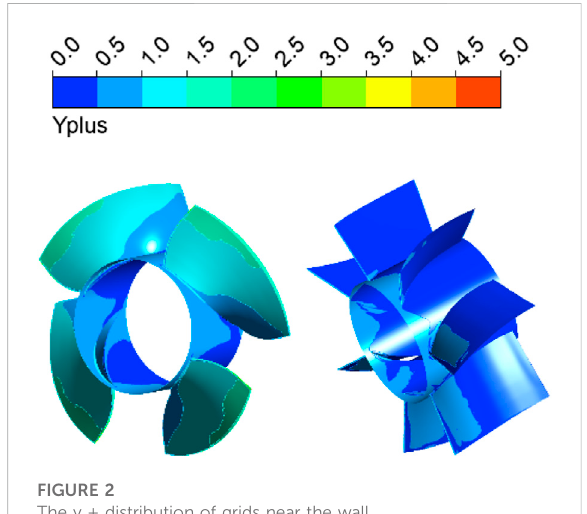
FIGURE 2 The y + distribution of grids near the